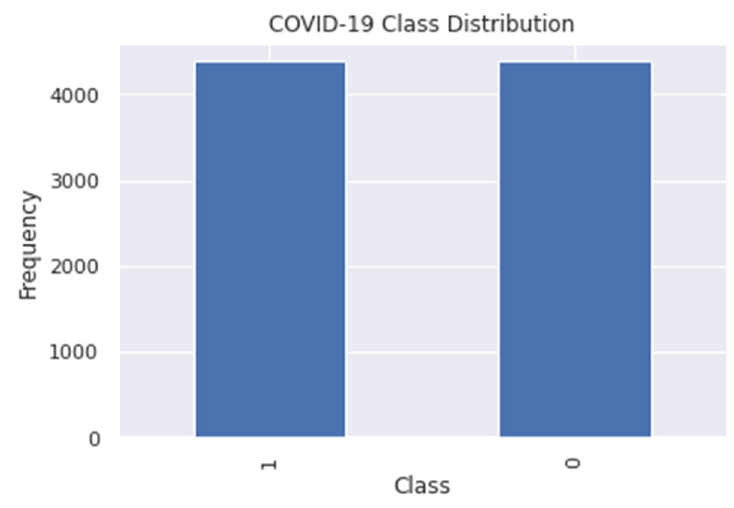
Figure 4. Bar plot of COVID-19 variable class distribution in the balanced dataset.